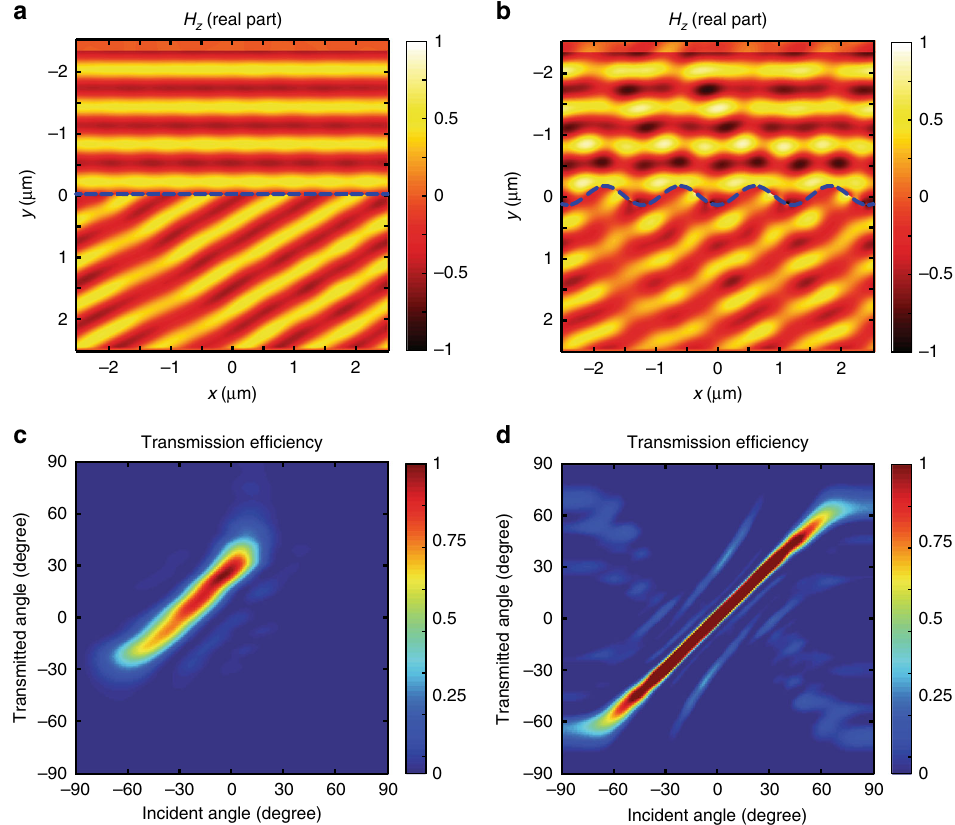
Fig. 3 Non-planar metasurface beam de fl ectors. Results of numerical simulation showing the magnetic fi eld intensity distribution of the beam de fl ector design, according to the generalised Snell laws, to refract light to an angle of π /6 rad. In the calculations, the incident light is a TM polarised plane wave propagating along the y -direction. a and b Grey intensity distributions of planar and sinusoidal beam de fl ector. Blue dashed lines indicate the position and geometry of the interfaces. c Transmission ef fi ciency of the sinusoidal metasurface in b as a function of the incident angle. d Transmission ef fi ciency of a conventional sinusoidal grating for comparison to